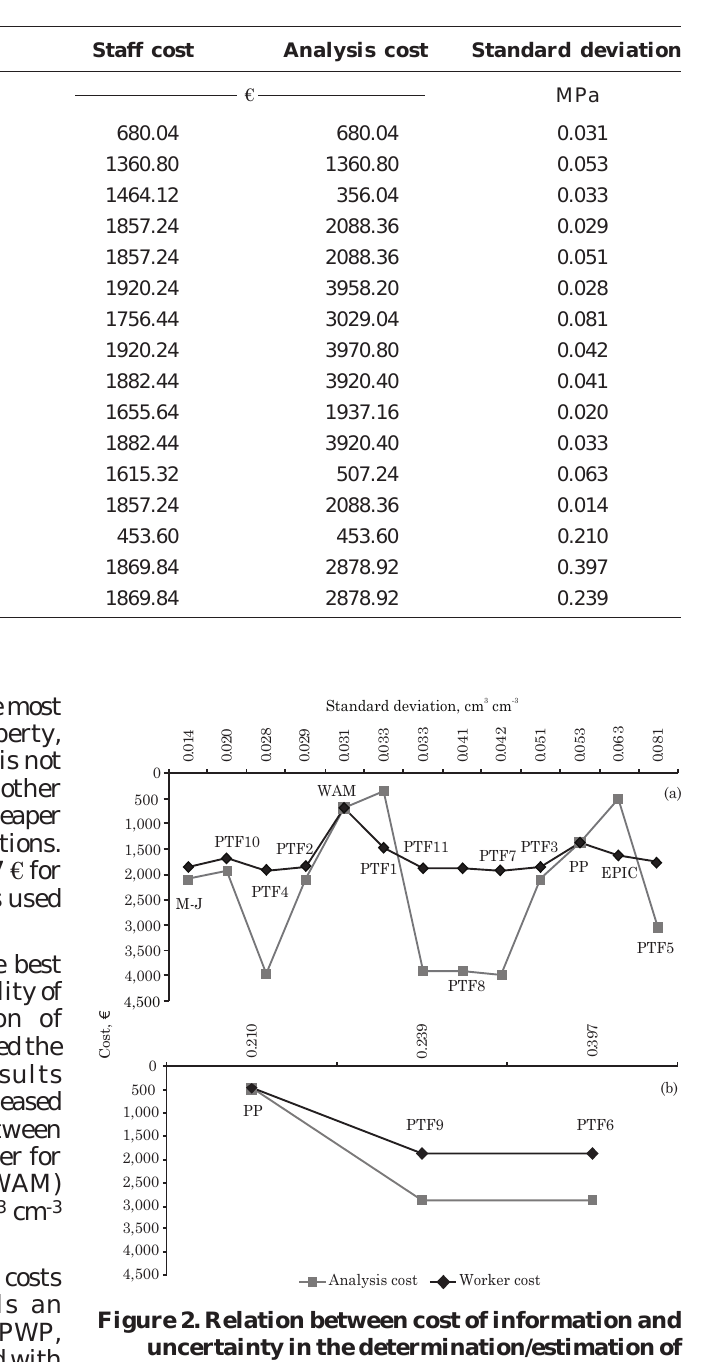
Table 5. Efficiency-related parameters (n=24)